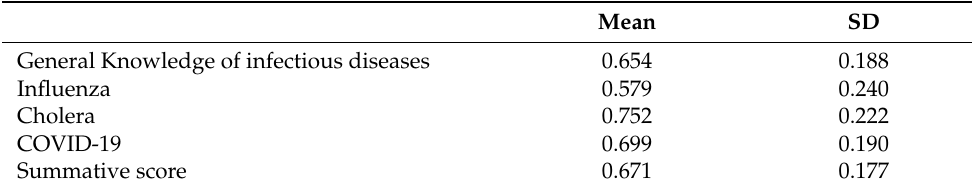
Table 1. The level of knowledge of the Ghanaian population on existing infectious diseases and